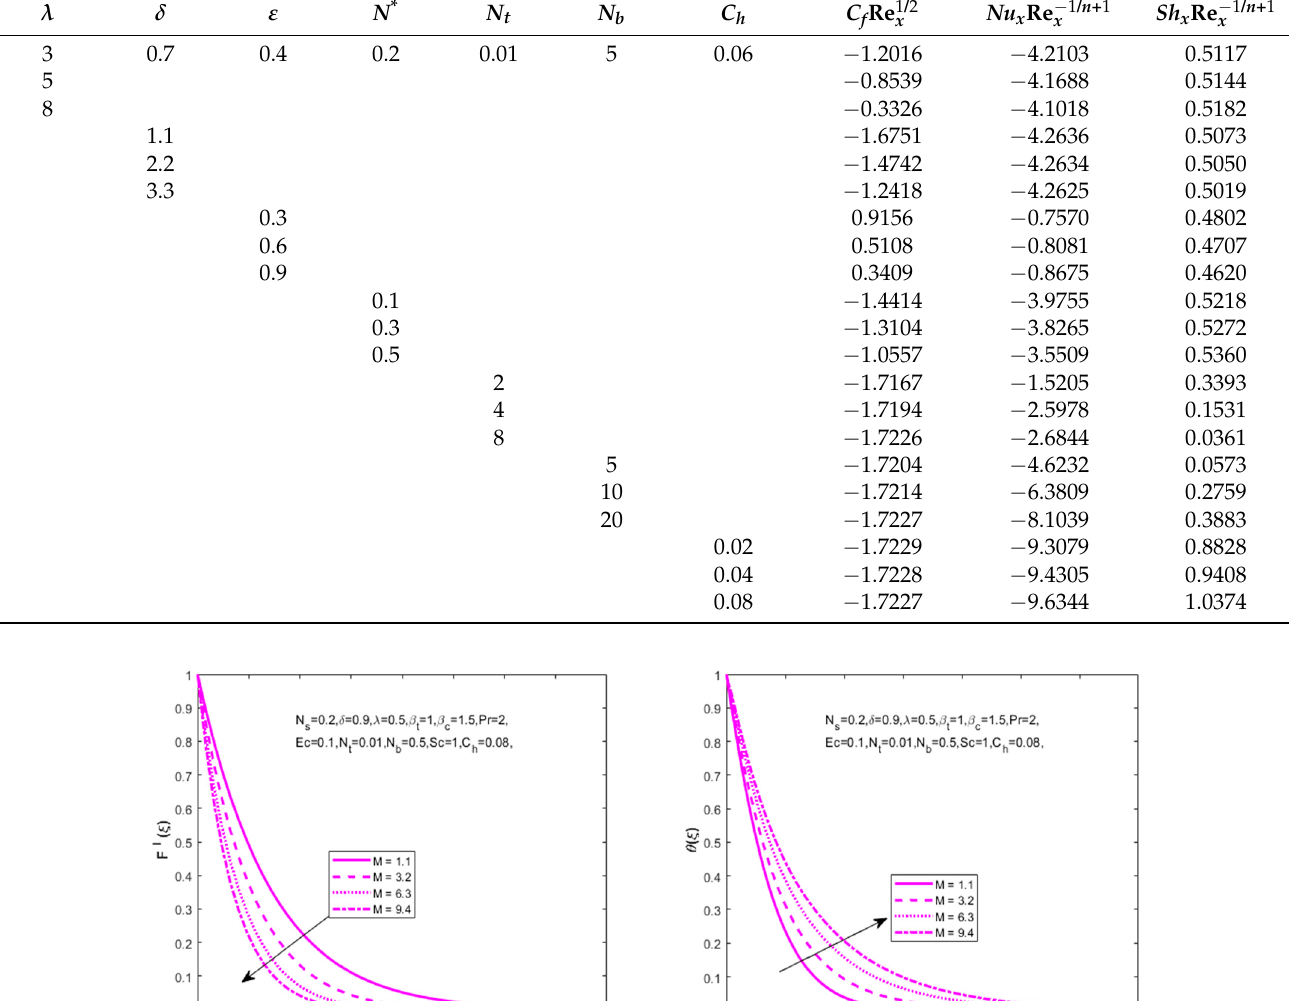
Table 2. Numerical values of Skin friction, Nusselt number and Sherwood number are as follows.